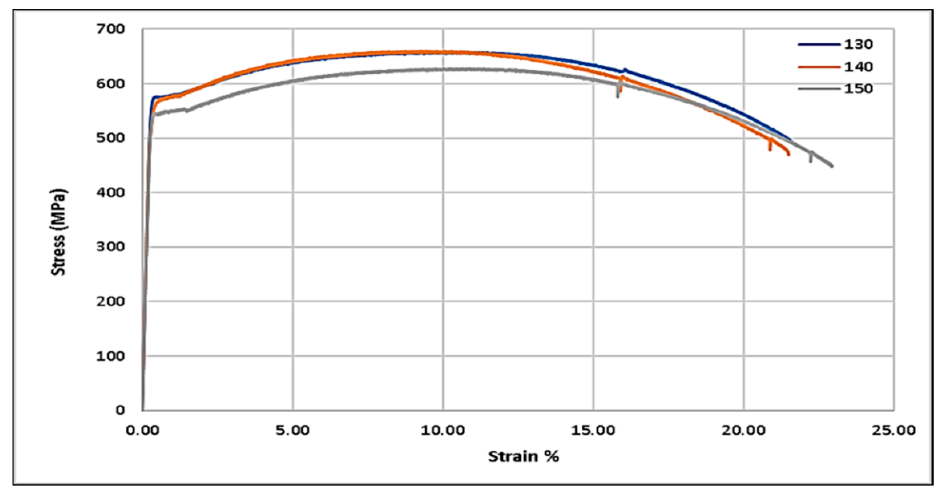
Figure 7. Stress–strain diagram comparing the average behavior of the tensile testing of 130, 140, and 150. Table 4. Number of beads per longitudinal/transverse layer.